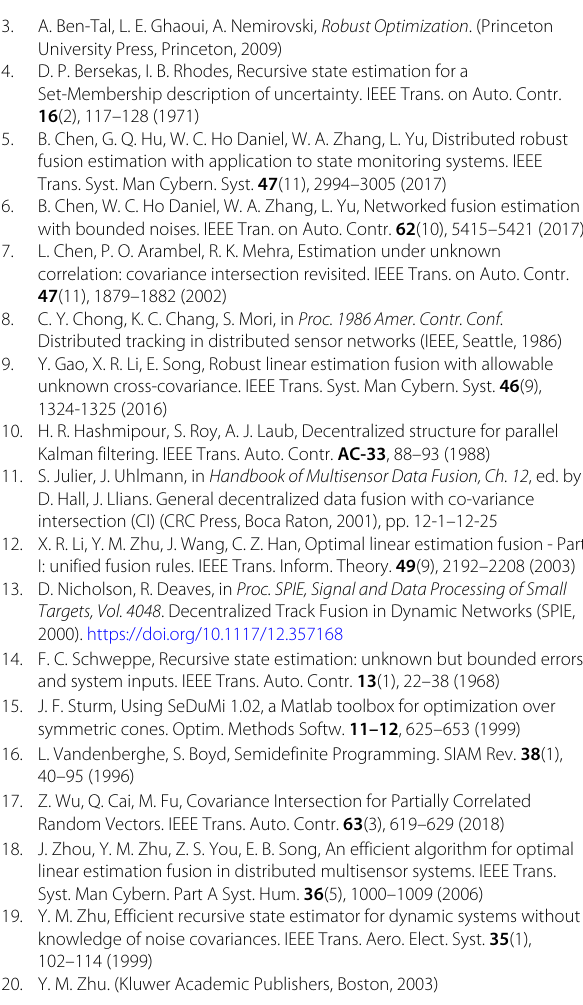
Fig. 26 The comparison of the second moments of the tracking errors